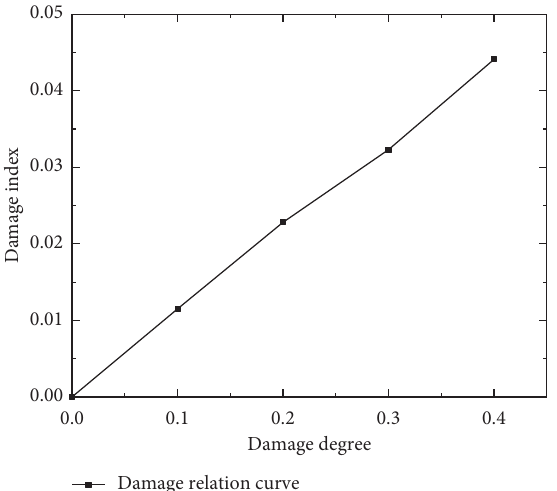
Figure 14: Damage relation curve of case